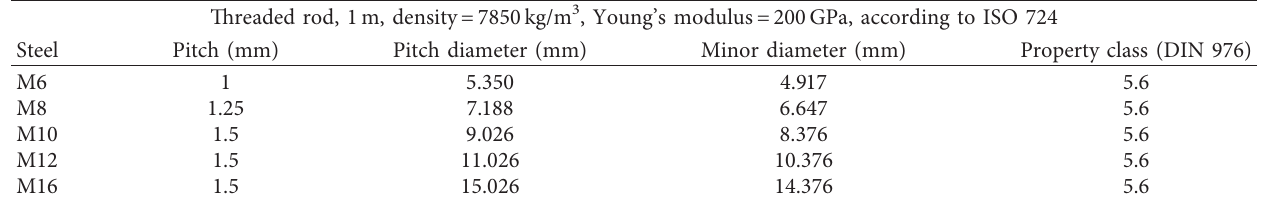
Table 2: Parameters of the